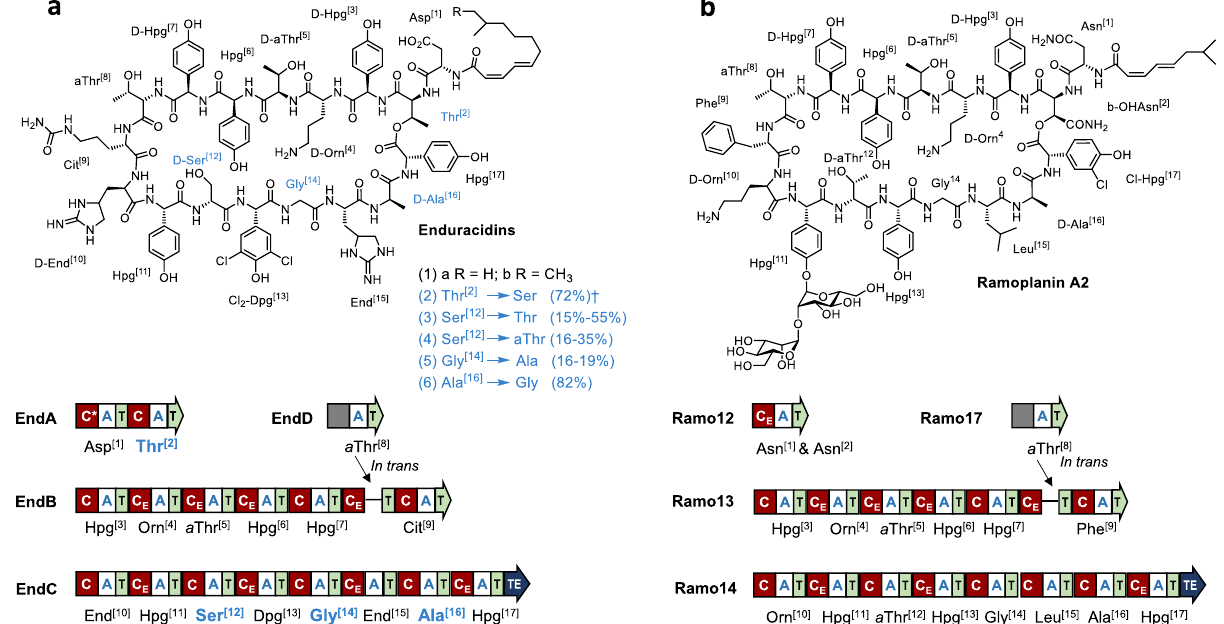
Fig. 1 Lipopeptide antibiotic structures and organization of NRPS assembly lines. a Structures of wild type and engineered enduracidins; amino acids in blue were targeted for modi fi cation, with organization of the enduracidin NRPS shown below. b Structure of ramoplanin A2 and organization of the ramoplanin NRPS. Nonproteinogenic amino acid abbreviations: 4-hydroxyphenylglycine (Hpg), ornithine (Orn), allo -threonine ( a Thr), citrulline (Cit), enduracididine (End) and 3,5-dichloro-4-hydroxyphenylglycine (Cl 2 -Dpg), 3-chloro-4-hydroxyphenylglycine (Cl-Hpg). † Titres of engineered products 2 – 6 relative to 1 produced by the wild type S. fungicidicus